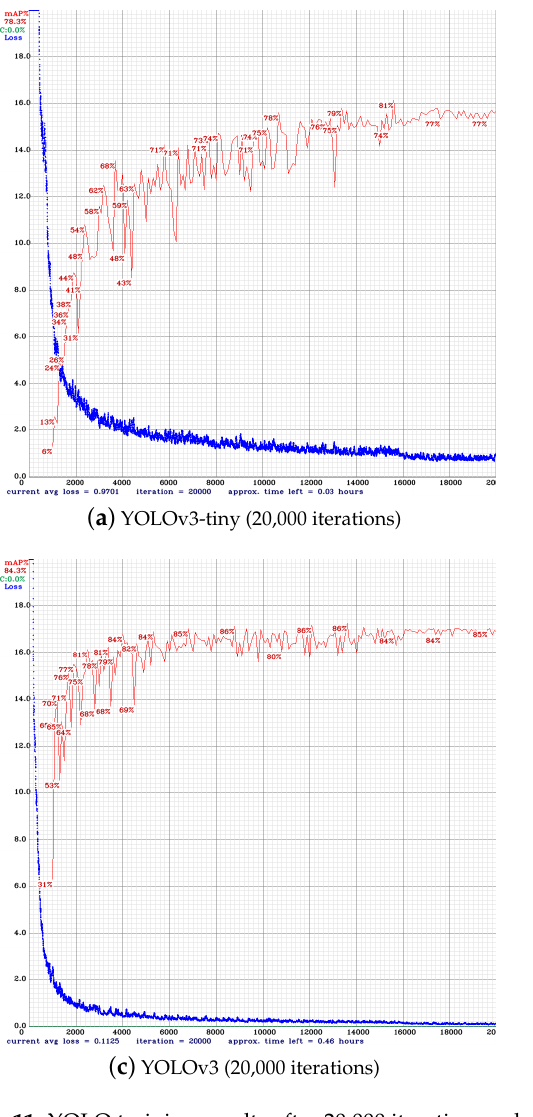
Figure 11. YOLO training results after 20,000 iterations, where we observe that YOLOv4-CSPdarknet53 shows higher loss as compared to YOLOv4-tiny and YOLOv3-darknet53 because ReLU performs better in terms of minimizing the loss rather than maximizing